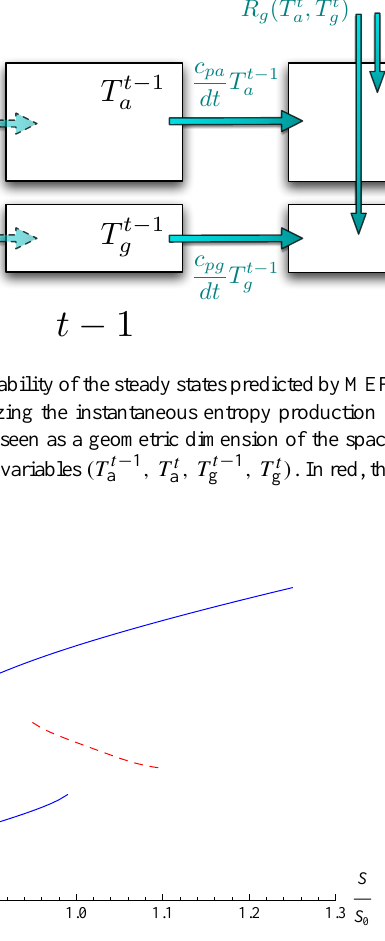
Fig. 11. Entropy Production maxima as a function of the solar con- stant, normalized by its present value. The solid lines (respectively the dotted line) correspond to dynamically stable (respectively un- stable) equilibria in the sense of Sect. 3.2. Note that this is not a bifurcation diagram in the usual